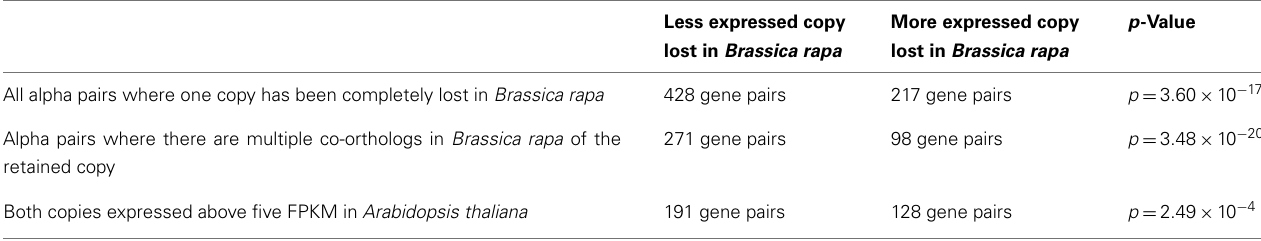
TableA1 | Expression in Arabidopsis and complete gene loss in Brassica rapa